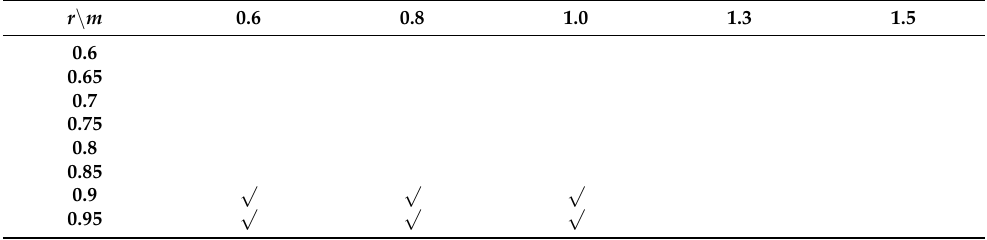
Table A2. Performance matrix for connections assembled by HEB160 column and IPE200 beam, with continuity plates, and steel grade is